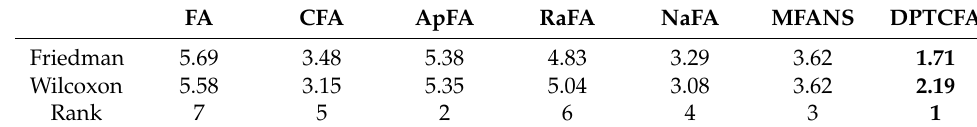
Table 8. The Friedman and Wilcoxon results in different algorithms ( D = 50).